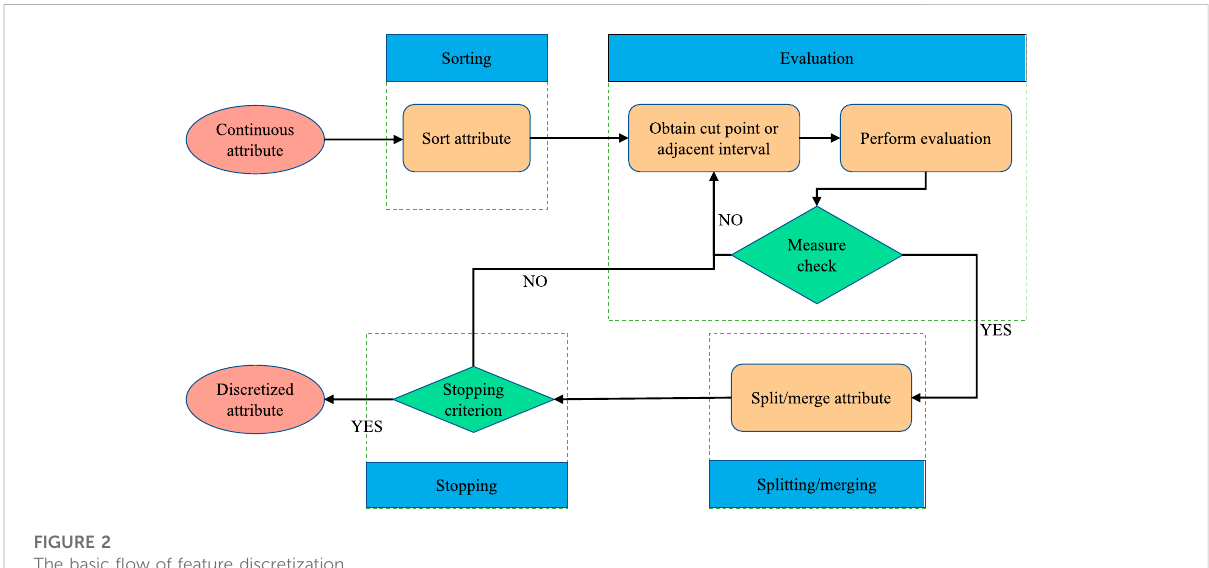
FIGURE 2 The basic fl ow of feature